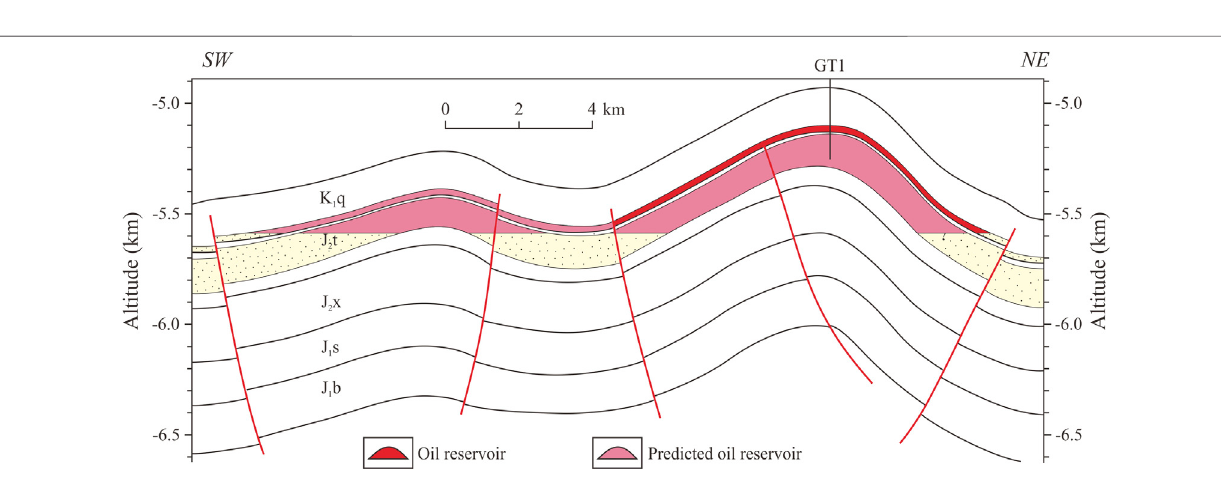
Frontiers in Earth Science |